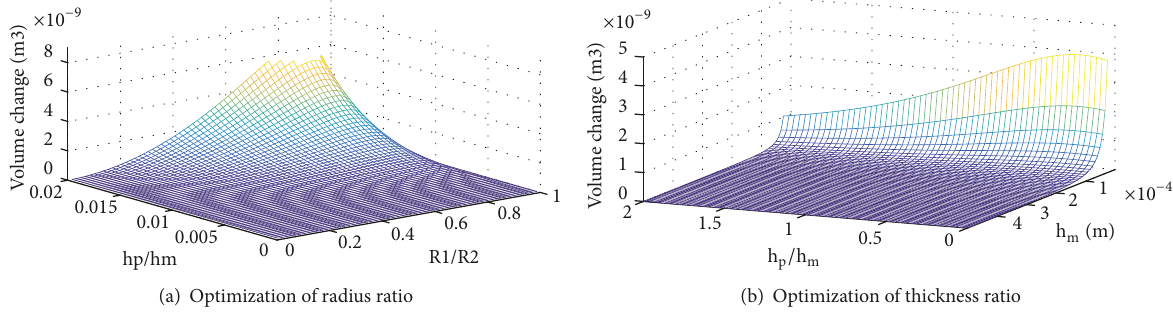
Figure 4: Static driving characteristics optimization of piezoelectric